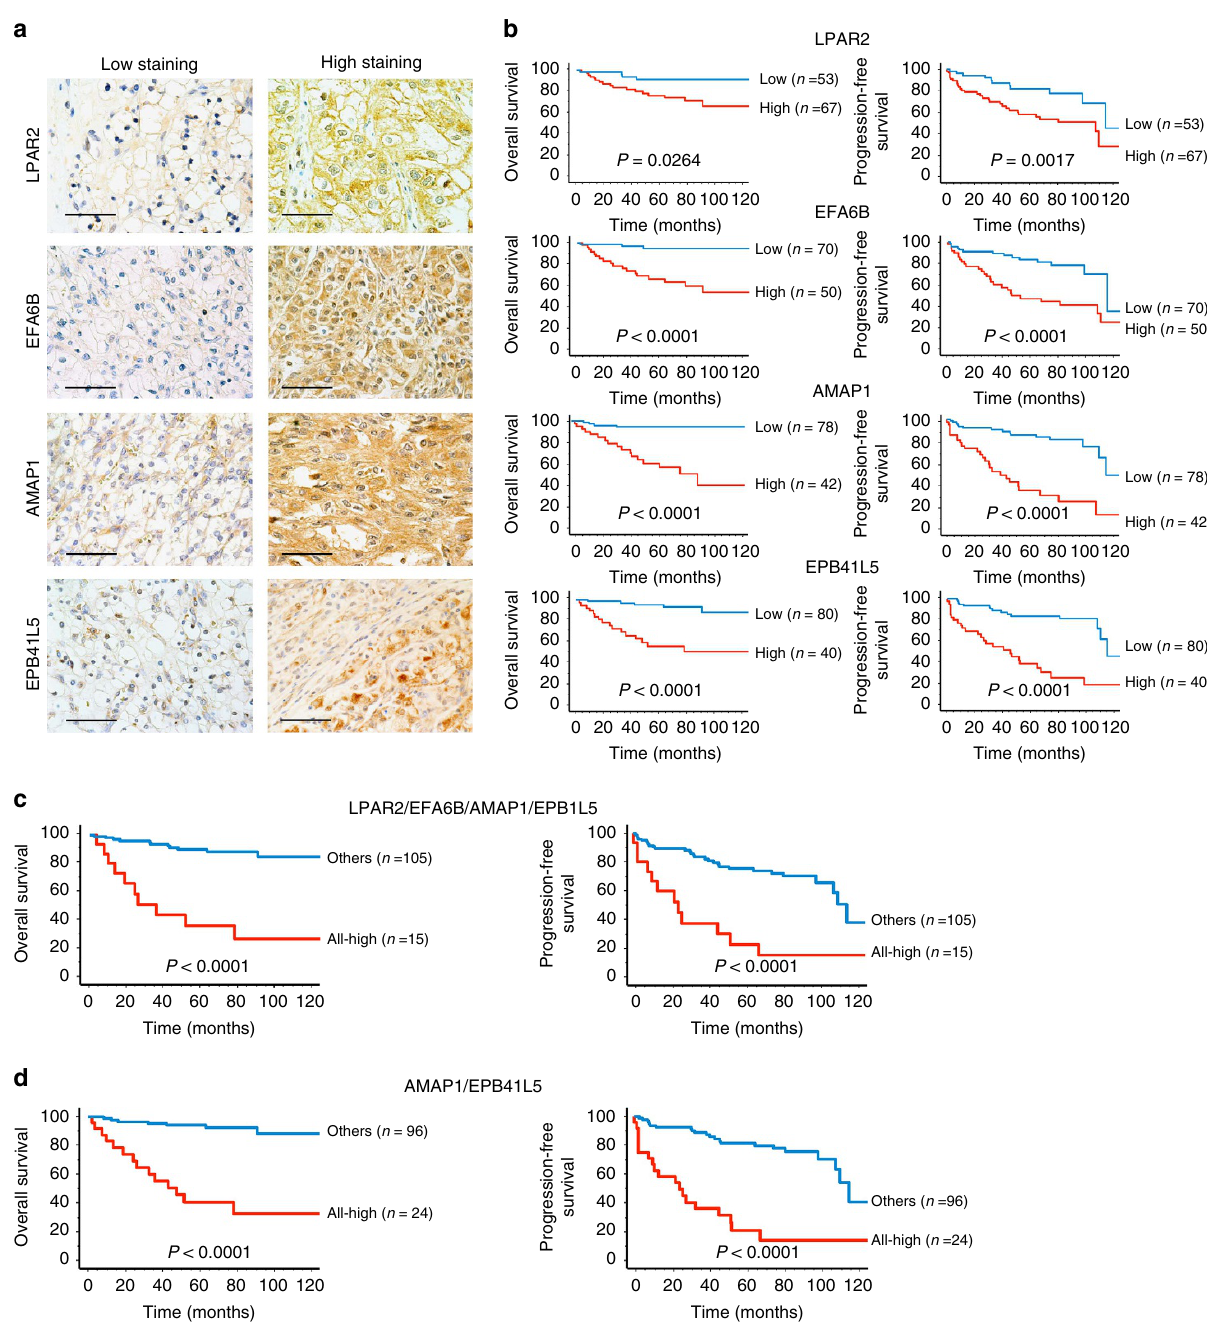
Figure 8 | The Arf6-based mesenchymal pathway in poor clinical outcome of ccRCC patients. ( a ) Representative images of immunohistochemical staining of LPAR2, EFA6B, AMAP1 and EPB41L5 in human primary ccRCC specimens. Scale bars, 50 m m. ( b – d ) Kaplan–Meier curves of the overall survival and progression-free survival of ccRCC patients ( n ¼ 120), with regard to the expression levels of each single component of the Arf6 pathway ( b ), with regard to the high expression of all components ( c ), and with regard to the simultaneous high expression of AMAP1 and EPB41L5 ( d ), as indicated. P values represent the results of the log-rank (Invitrogen), according to the manufacturer’s instructions. Two different sequences (G a 12QL), G a 13 (G a 13QL) and G a q (G a qQL) were purchased from Addgene were used for each target, unless otherwise described. The siRNAs used for (46825, 46828 and 46826, respectively). A cDNA encoding the dominant-negative the knockdown of Rac1 and RhoA were from Life Technologies (for Rac1, mutant of G a 12, namely, G a 12G230A (G a 12GA), was generated by PCR 4390824-s11711, 4390824-s11712; for RhoA, 4390824-s758, 4390824-s759). and ligated into the Bam HI/ Nhe I site of the psd44-puro plasmid. HA-tagged Oligonucleotide duplexes bearing an irrelevant sequence were from Dharmacon. dominant-negative Arf6 (T27N) cDNA in the pcDNA3 vector was as described For stable shRNA-mediated gene silencing, pLKO.1-puro-based recombinant previously 9 . Oligonucleotides used for the PCR reactions are summarized in lentiviruses were generated. In brief, shRNAs were constructed in pLKO.1-puro Supplementary Table 1. from the Sigma Mission shRNA library (for LPAR2, TRCN0000011375; for RNA interference and transfection . For transient siRNA-mediated gene EFA6B, TRCN0000427083; for EPB41L5, TRCN0000130203; for Arf6, TRCN0000294069, TRCN0000048003, Sigma-Aldrich) and a control scramble silencing, cells were transfected with 50nM each of the corresponding siRNA shRNA in pLKO.1-puro (1864, Addgene) were transfected into 293FT cells, oligonucleotide duplexes (Japan BioService) using Lipofectamine RNAi Max